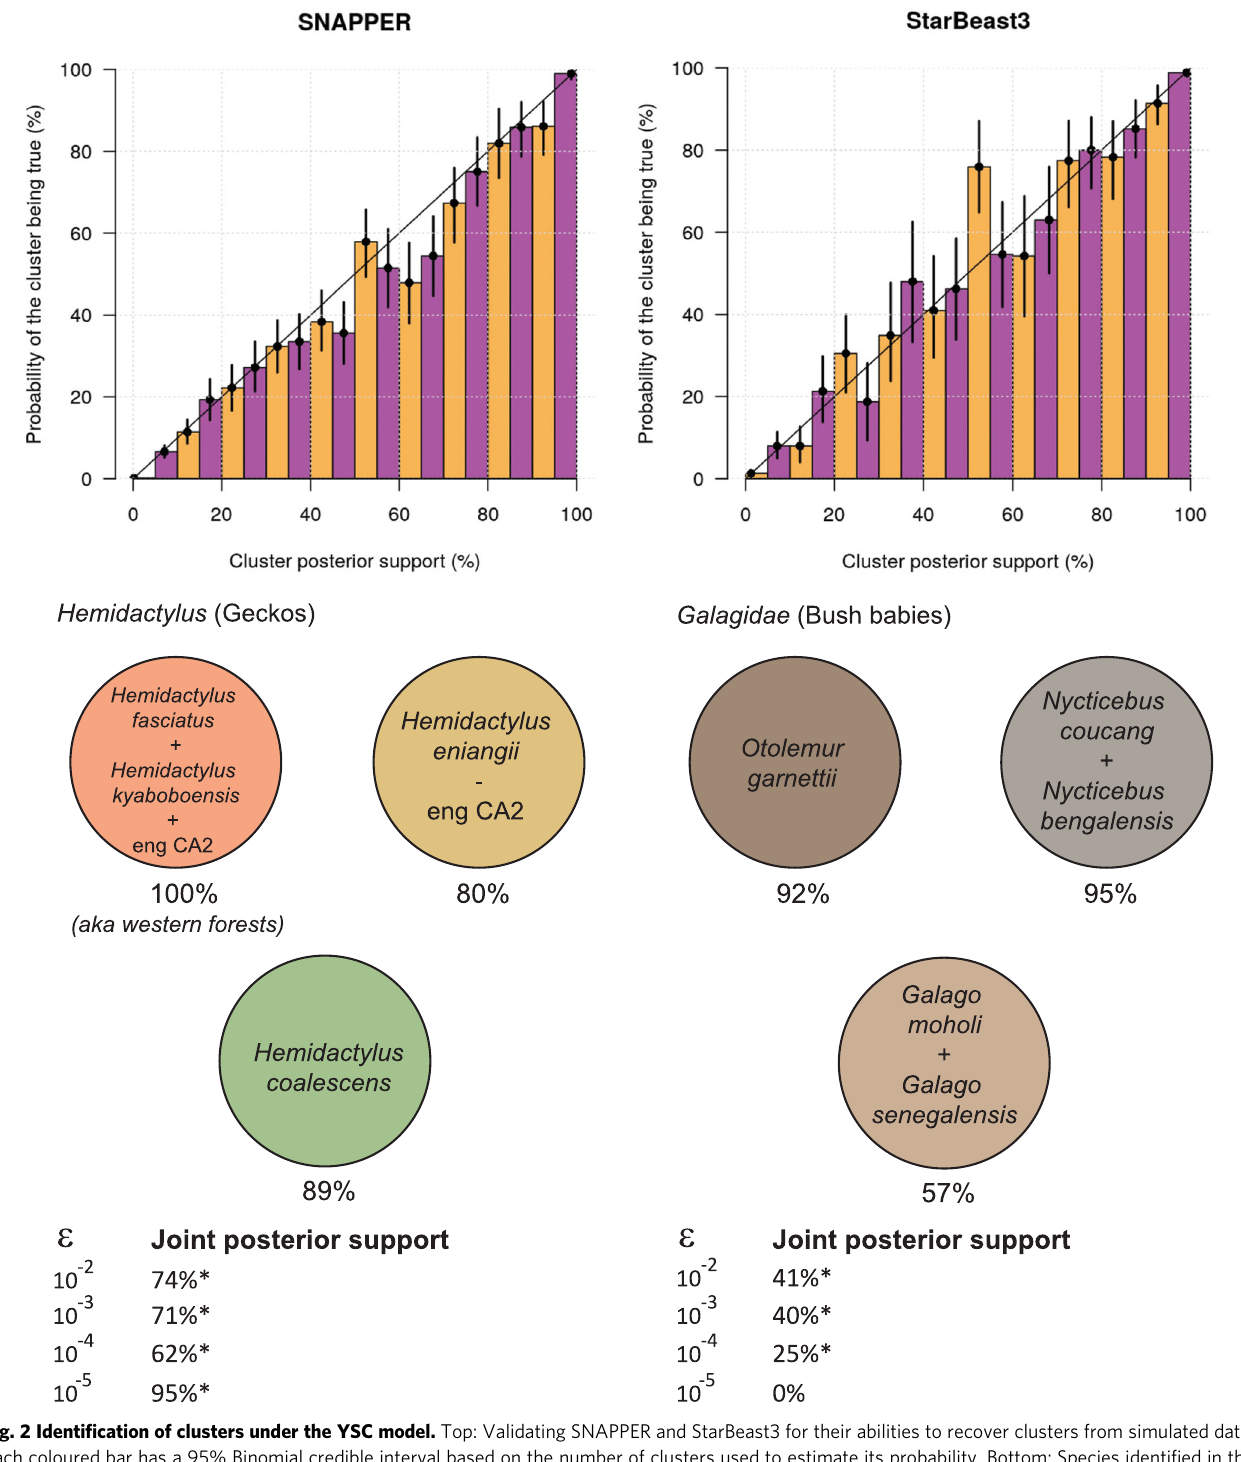
are fairly understudied compared with other primates and their taxonomy is cryptic 35,36 .